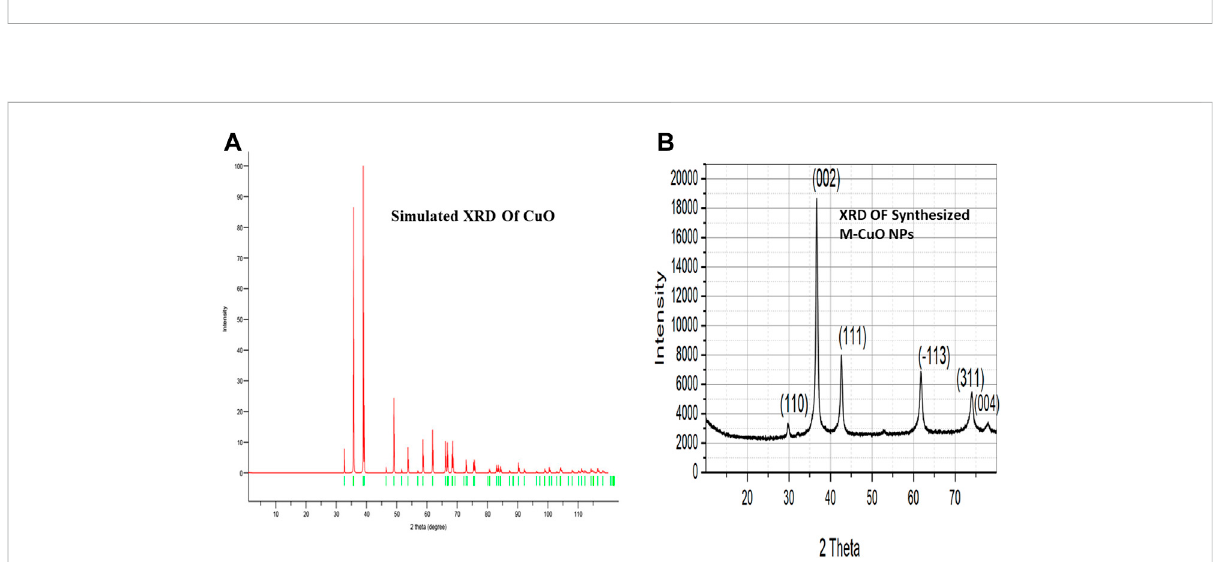
FIGURE 3 (A) . Simulated XRD of M-CuO NPs. (B) . XRD of Synthesized M-CuO